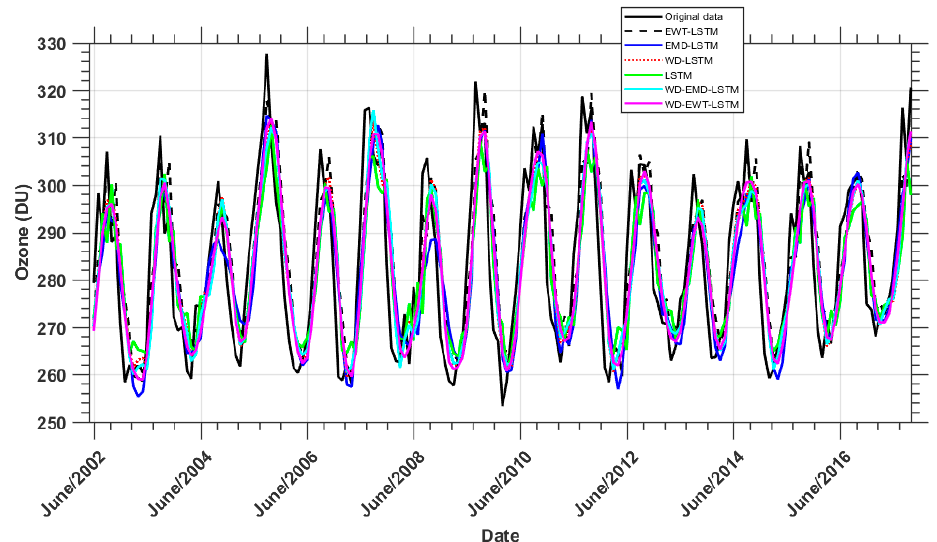
Figure 9. Forecasting results of the OCBA TCO time series for the period of June 2002 to December 2017 as derived by the use of six models (LSTM, EWT-LSTM, EMD-LSTM, wavelet denoising (WD)-LSTM, WD-EWT-LSTM, and WD-EMD-LSTM) together with the TCO monthly mean values derived from observations (original data).